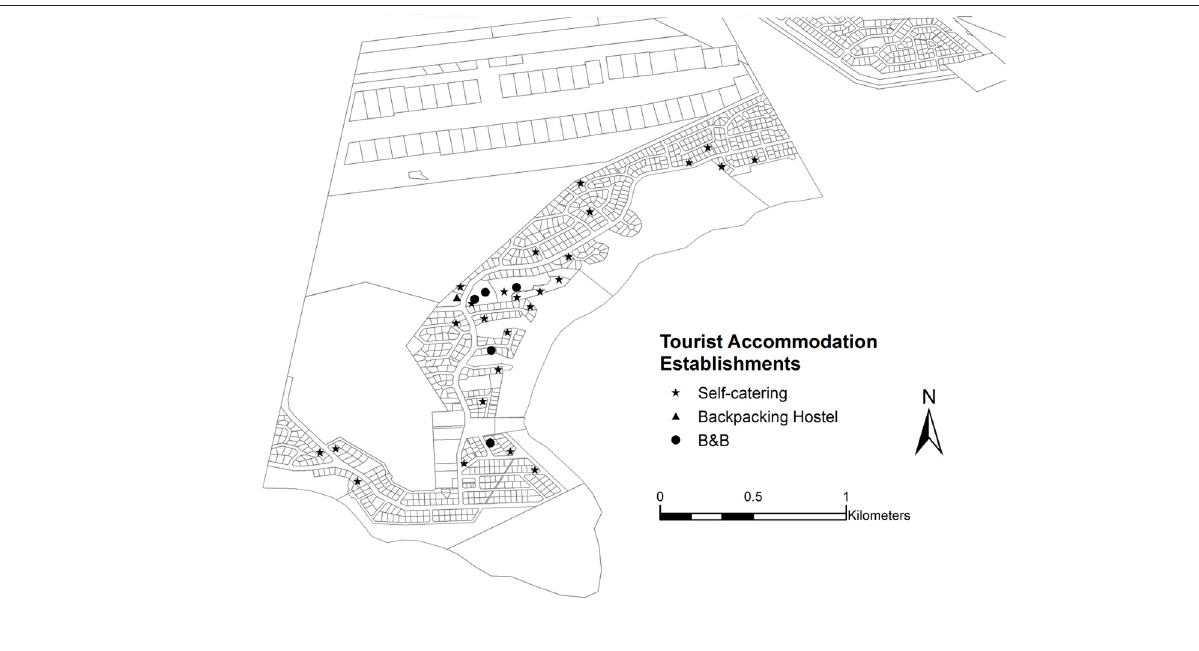
Source: Authors’ map drawn for the study Figure 3: Map indicating the locations and types of accommodation establishments in Cape St